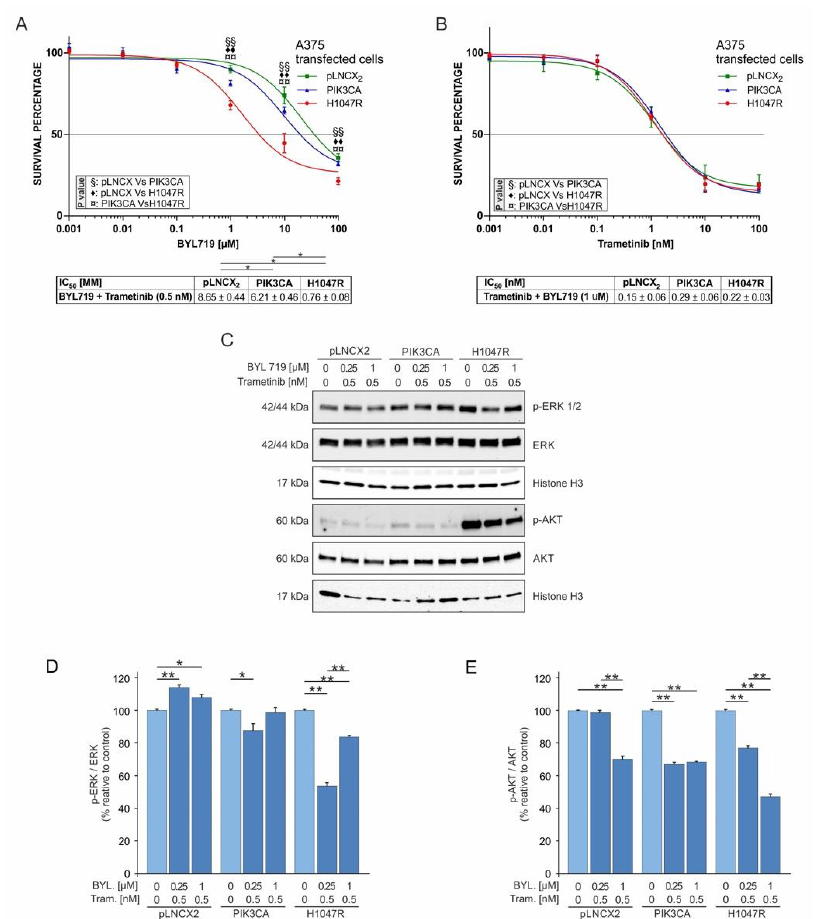
Figure 7. BYL719 and trametinib combined treatment of A375 transduced cells. ( A ) Cell viability (MTT assay 72 h) of A375 transduced cells treated with 0.5 nM trametinib and increasing doses of BYL719 (0.001–100 µ M) for 72 h. ( B ) MTT assay was performed to evaluate A375 transduced cells’ viability after treatment with 1 µ M BYL719 and increasing doses of trametinib (0.001–100 nM) for 72 h. ( C – E ) p-ERK, p-Akt, total ERK, and total Akt protein levels in A375 transduced cells treated with 0.5 nM trametinib and growing doses of BYL719 (0.0–0.25–1 µ M) at 48 h were evaluated by Western blot. All experiments were performed in triplicate. The statistical significance of the two-tailed Student’s t -test was in reference to the control. * p < 0.05; ** p < 0.01; (cid:117)(cid:117) , §§, ¤¤ = p ≤